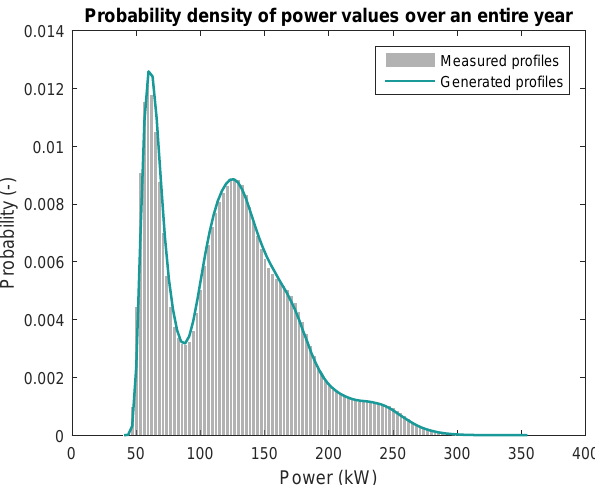
Figure 4. Comparison of measured and generated profiles for two week and weekend days in January for 30 ( top ) and 300 ( bottom ) households.